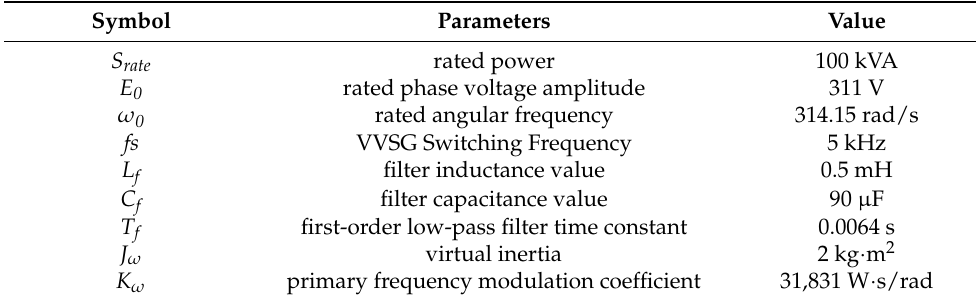
Table 1. Main parameters of simulation model.